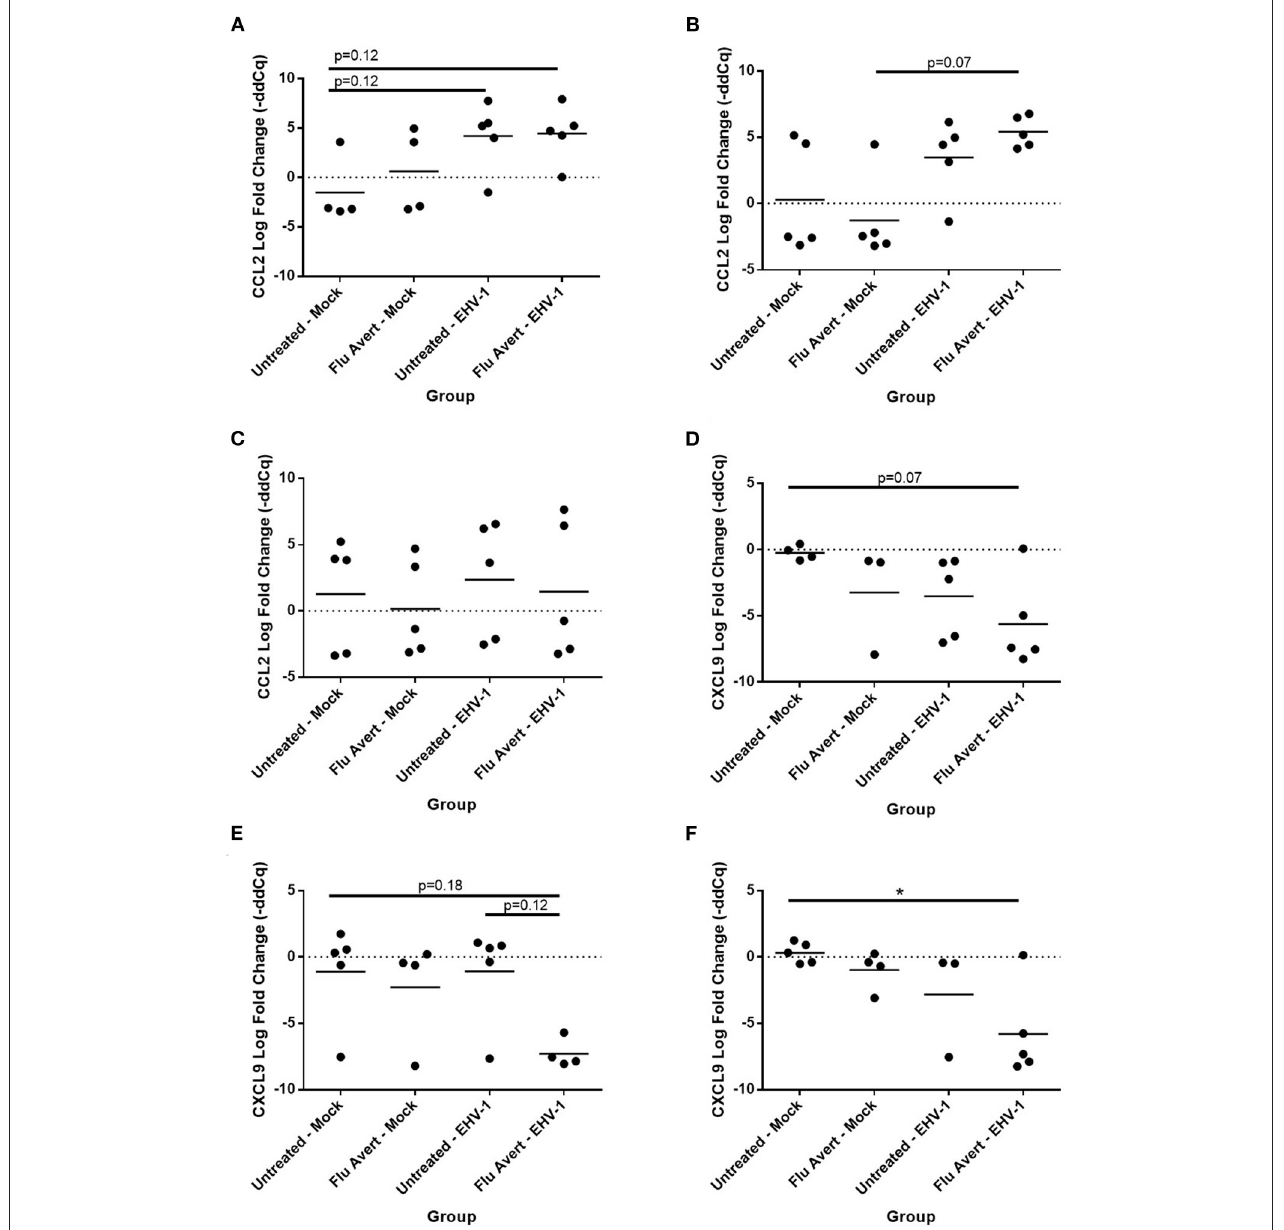
FIGURE 6 | Effect of Flu Avert treatment on chemokine mRNA expression in ERECs collected from five horses 72h following EHV-1 inoculation. (A) CCL2 mRNA expression in ERECs that were treated with Flu Avert on day 2 prior to EHV-1 inoculation. (B) CCL2 mRNA expression in ERECs that were treated with Flu Avert on day 5 prior to EHV-1 inoculation. (C) CCL2 mRNA expression in ERECs that were treated with Flu Avert on day 7 prior to EHV-1 inoculation. (D) CXCL9 mRNA expression in ERECs that were treated with Flu Avert on day 2 prior to EHV-1 inoculation. (E) CXCL9 mRNA expression in ERECs that were treated with Flu Avert on day 5 prior to EHV-1 inoculation. (F) CXCL9 mRNA expression in ERECs that were treated with Flu Avert on day 7 prior to EHV-1 inoculation. The mean log fold change (–ddCq) is represented by a bar (* p < 0.05).